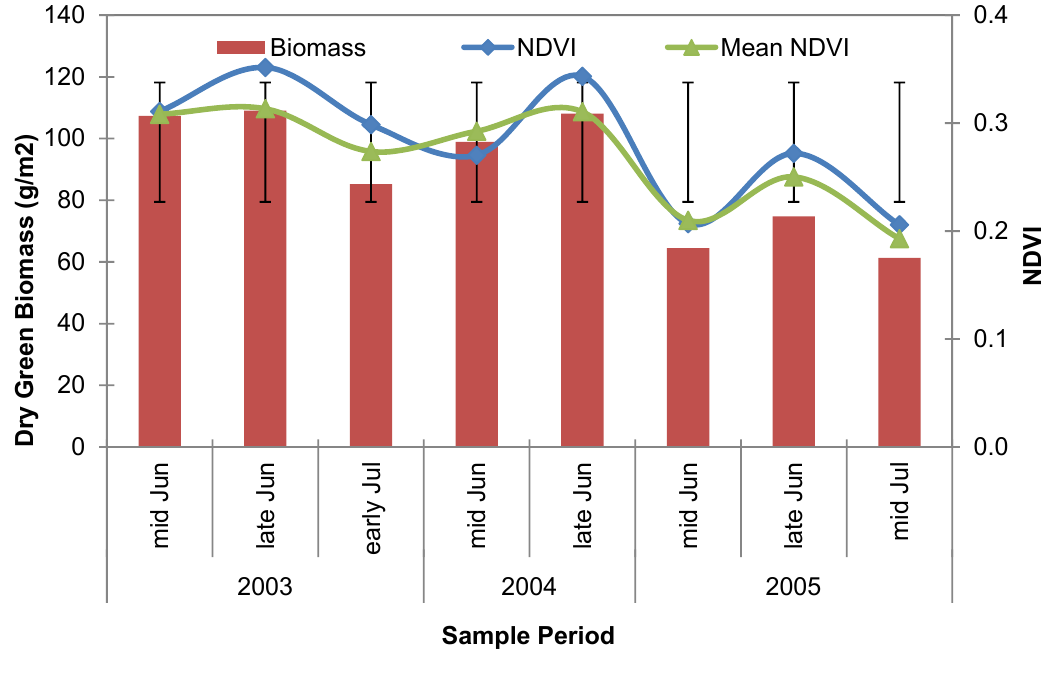
Figure 2. Biomass versus NDVI averaged across the specific sampling sites and the mean NDVI averaged across the entire west block of GNP from mid-June to mid-July in 2003, 2004, and 2005 (The error bars of NDVI are shown with 1 stand